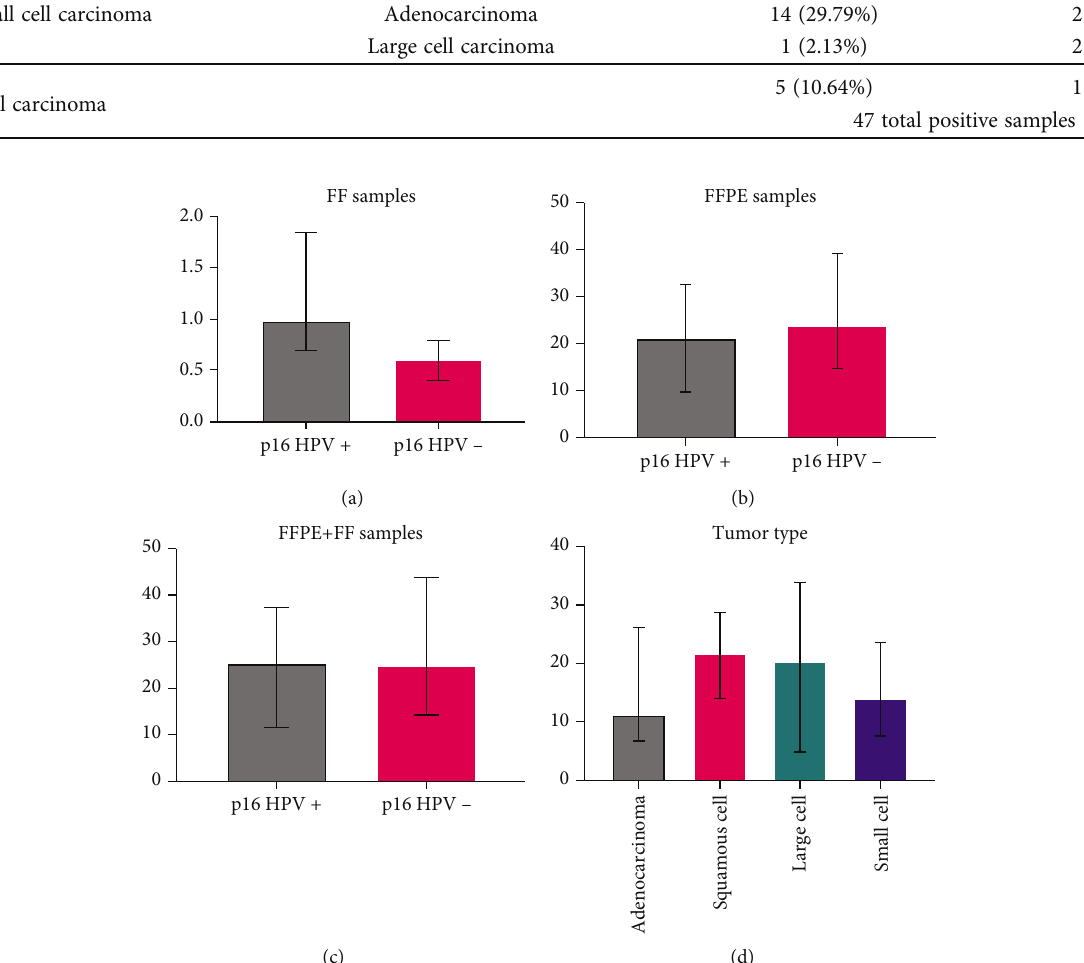
Figure 1: p16 expression pro fi le. (a) p16 expression in HPV+ FF samples. Di ff erences between both groups were compared by the Mann – Whitney test. No statistical signi fi cance was found for p < 0 : 05 , and the medians were 0.9752 for HPV+ and 0.5960 for HPV -; (b) p16 expression in HPV+ and HPV- FFPE samples. Rank plot from the Mann – Whitney test with median and interquartile range. The medians were 45.20 for HPV+ and 46.81 for HPV-, and no statistical signi fi cance was found for p < 0 : 05 ; (c) p16 expression in HPV+ and HPV- FFPE and FF samples. The medians were 41.32 for HPV+ and 39.16 for HPV-; no statistical di ff erence was found for p < 0 : 05 ; (d) p16 expression di ff erence in all tumors — median and interquartile rank analysis by the Kruskal-Wallis test. The medians of p16 expression were as follows: adenocarcinoma 32.33; squamous cell carcinoma 53.10; large cell carcinoma 50.01; and small cell carcinoma 42.92. No signi fi cant statistical di ff erence was found for p < 0 : 05